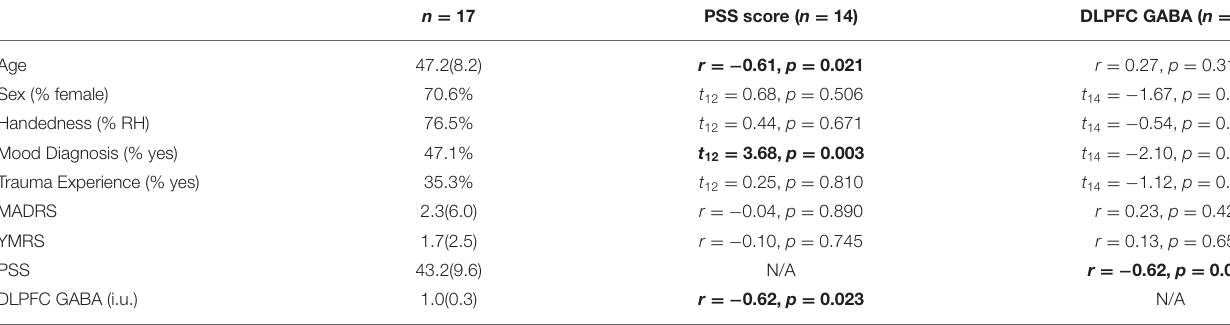
TABLE 1 | Demographic, clinical characteristics, and relevant relationships with PSS scores and DLPFC GABA.